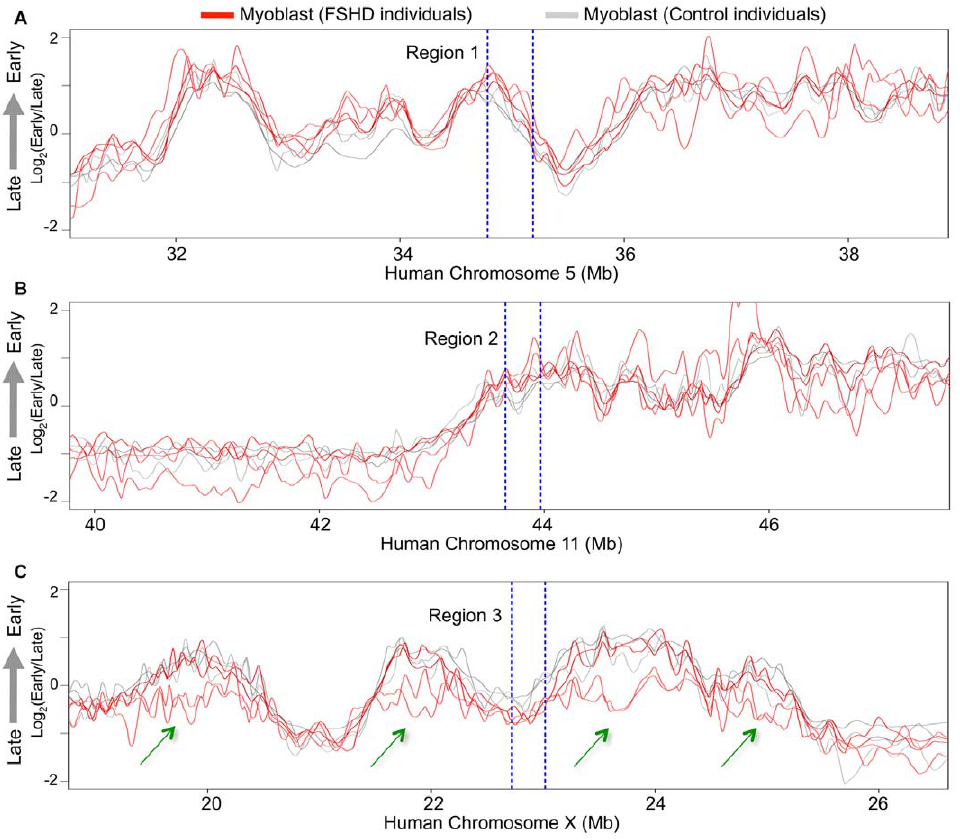
Figure 5. Regions of greatest statistical difference between control and FSHD myoblast replication timing profiles. (A, B, C) Primary human myoblast replication timing profiles are shown for 3 control (gray) individuals and 4 FSHD (red) patients across the top three 200 kb regions (on chromosomes 5, 11, and X respectively) of greatest difference as identified using a distance-maximizing statistical method [39]. Each 200 kb region of greatest difference between FSHD and control myoblasts is flanked by dashed, blue lines. Green arrows in panel C mark regions with gender-dependent differences caused by X-chromosome inactivation. The two lower curves in these regions are from the two female-derived myoblast samples and the other curves are myoblasts from males.